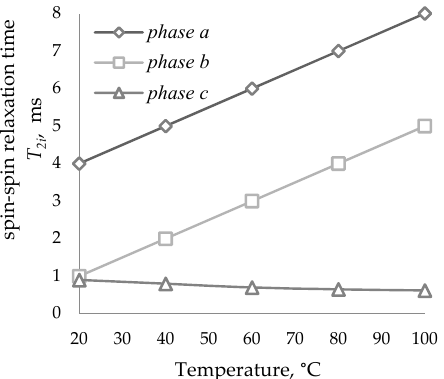
Figure 1. Spin–spin relaxation time T 2 i of HRO vs. temperature.